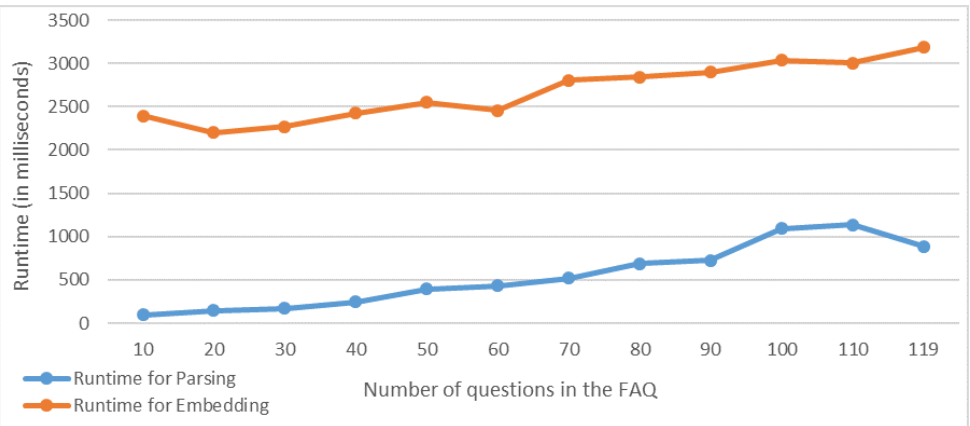
Figure 4. Benchmarks for powering the Instant Expert from an FAQ webpage: parsing time and embedding